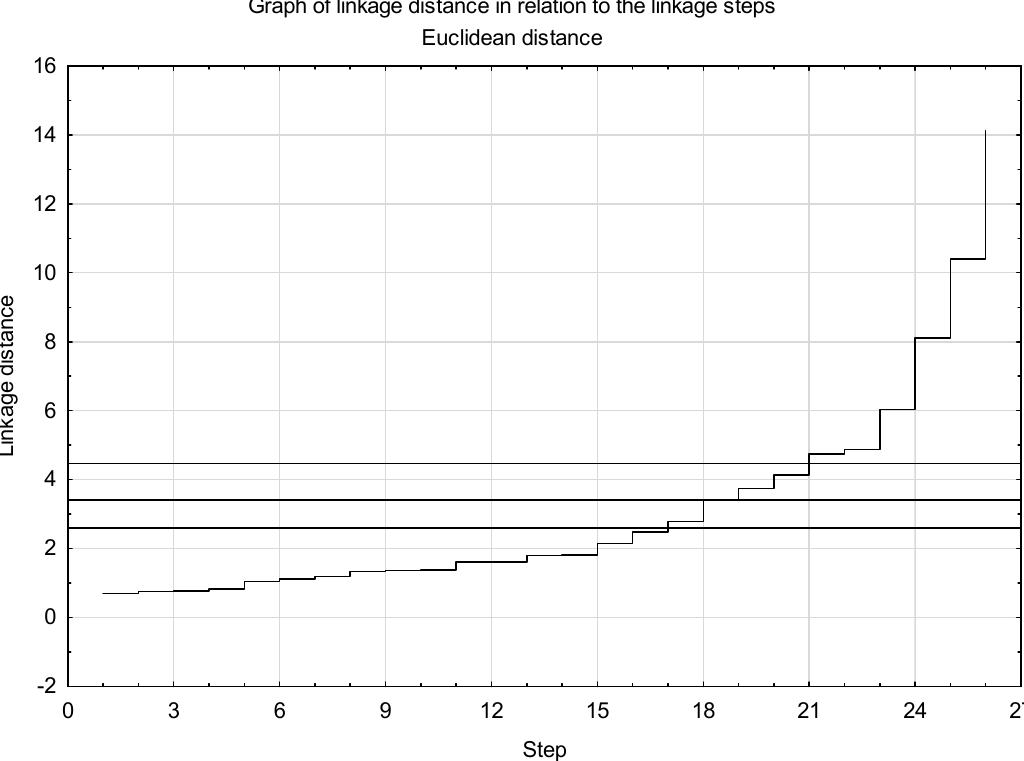
Figure 1. The course of agglomeration in the EU countries and the USA depending on the production potential of the agricultural sector. Source: The authors’ calculations based on [58–63].